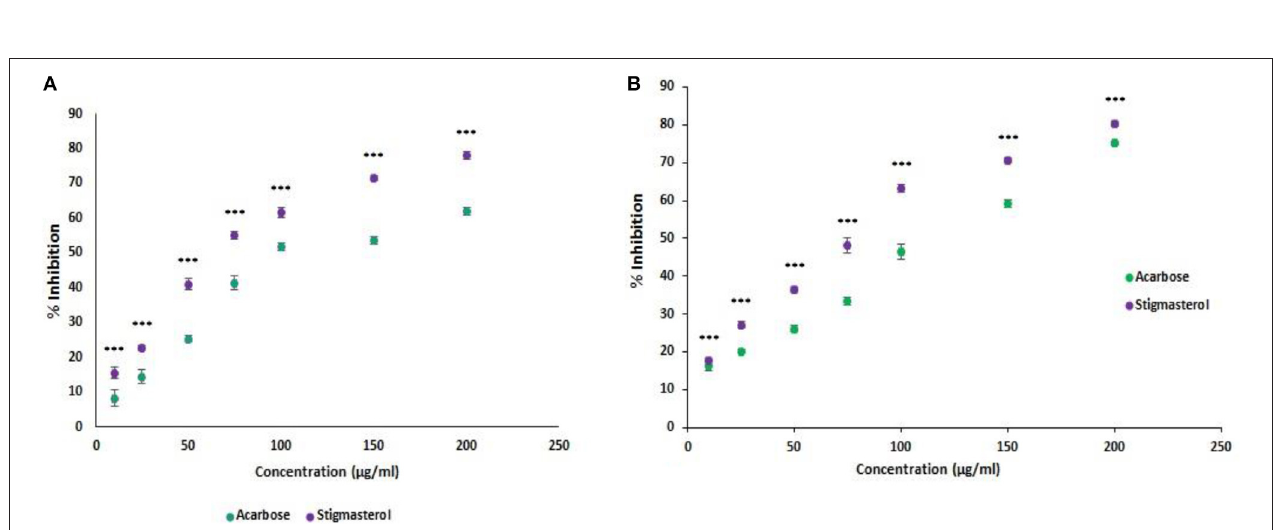
FIGURE 2 | (A) Fourier-transform infrared spectrometry spectrum showing the characteristic peaks of stigmasterol (B,C) Gas chromatography–mass spectrometry spectrum showing the presence of stigmasterol.